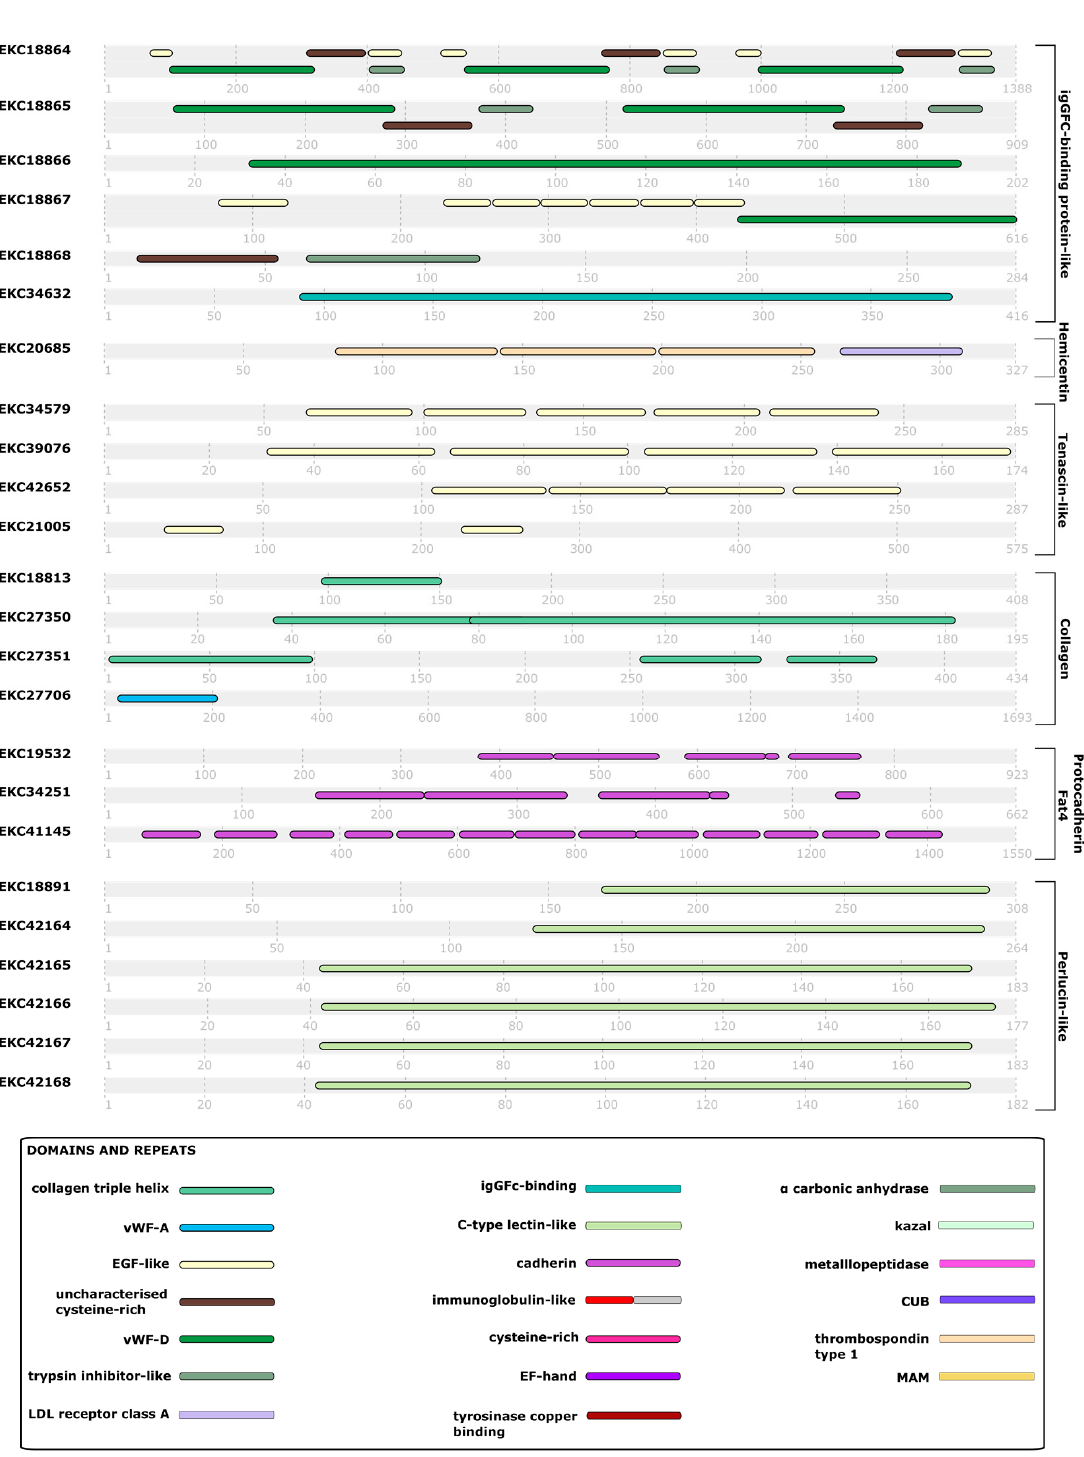
Figure 1. Conserved domains and repeated sequences predicted by the InterPro program (Finn et al., 2016) [25] among 38 sequences specifically expressed at the pediveliger stage in Crassostrea gigas , based on transcriptomic data published by Zhang et al. (2012) [24].